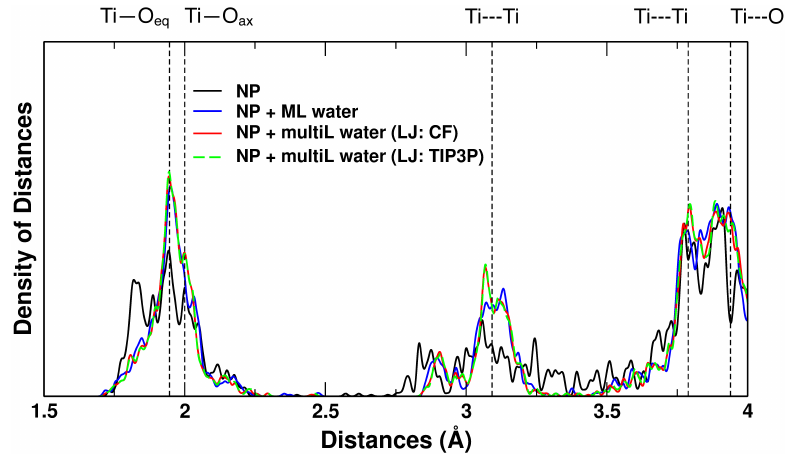
Figure 5. Distances-distribution (simulated EXAFS) computed with B3LYP for the bare NP (black), the NP with the adsorbed water monolayer (ML, blue), computed with QM / MM for the NP with the water multilayer using the CF LJ (multiL, red) and using the TIP3P LJ (multiL, dashed green). Dashed black lines correspond to the anatase bulk Ti—O, Ti --- Ti and T --- O